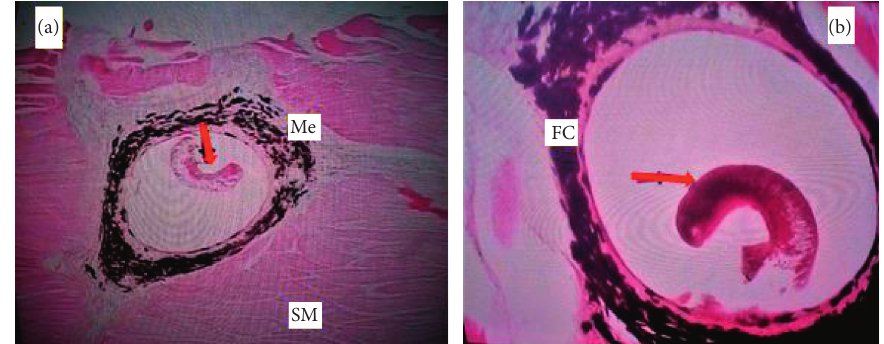
Figure 2: Photomicrographs of encysted metacercaria of Neascus spp. (red arrow). The fish surrounds the cyst with black pigmented melanin produced by melanomacrophages in response to the parasite. FC, fibrous capsule; Me, melanomacrophages and pigment; SM, muscle tissue.